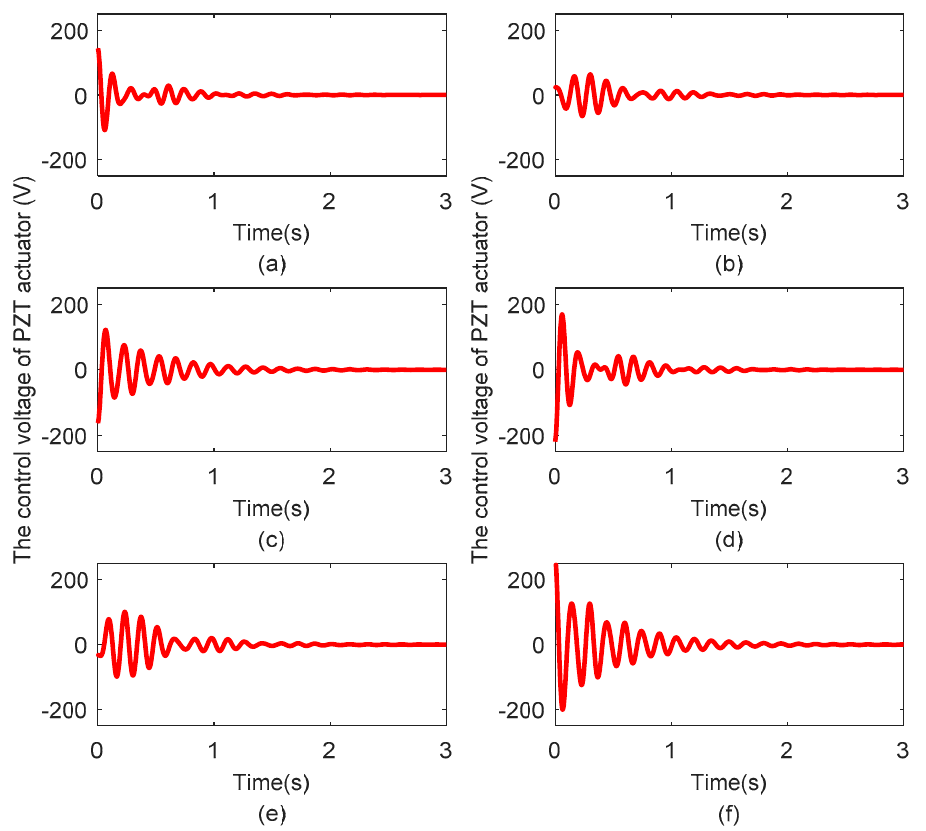
Figure 12. ( a – f ) Control voltages exerted on PZT actuator pairs 1, 2, 3, 4, 5, and 6,